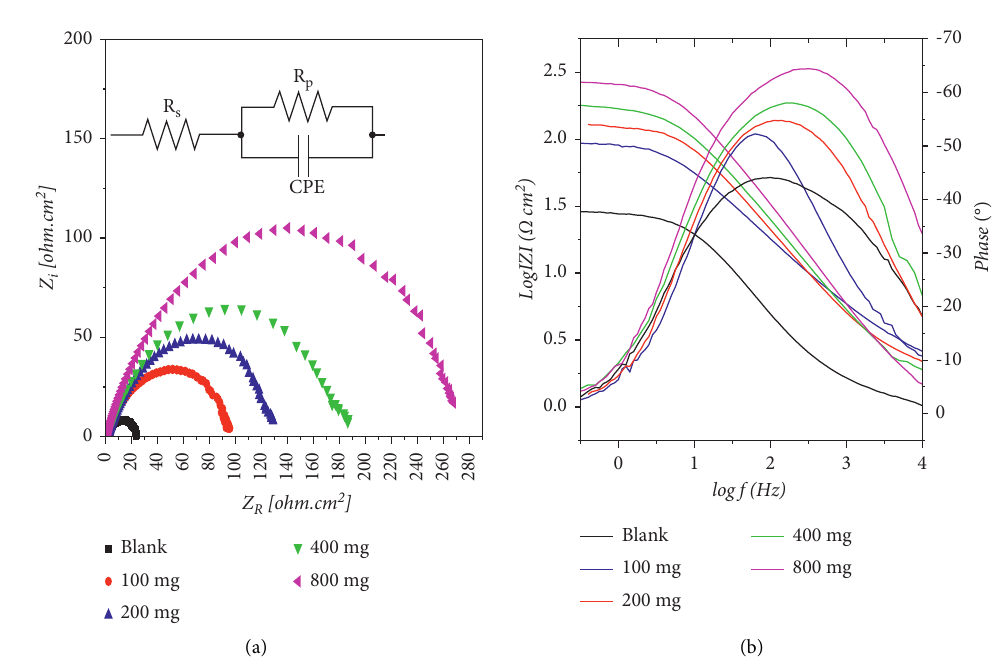
Figure 8: (a) Nyquist plots in the absence and presence of a different concentration of EEW, equivalent circuit used, and (b) bode-phase angle plots in the absence and presence of a different concentration of EEW.